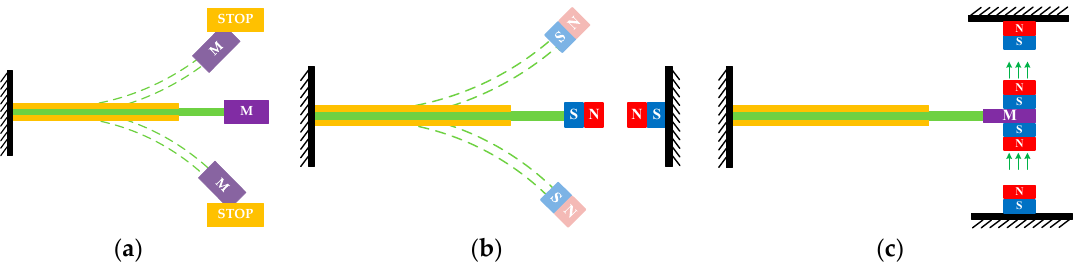
Figure 1. Schematic diagram of common nonlinear optimization methods: ( a ) Stop Blocking Method; ( b ) Multi-Stable Method; ( c ) Vertical Magnetic Method.